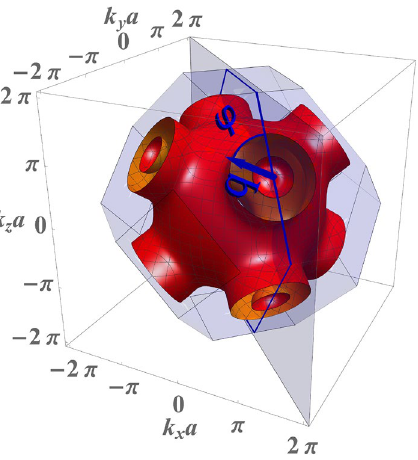
Fig. 7 Open Fermi-surface of the same conduction band as in Fig. 2, but with FL lowered by 0.08 eV. We can see the appear- ance of additional sheets of the FS in the form of small spheroidal “lenses” inside the “necks” in the vicinity of the L-points